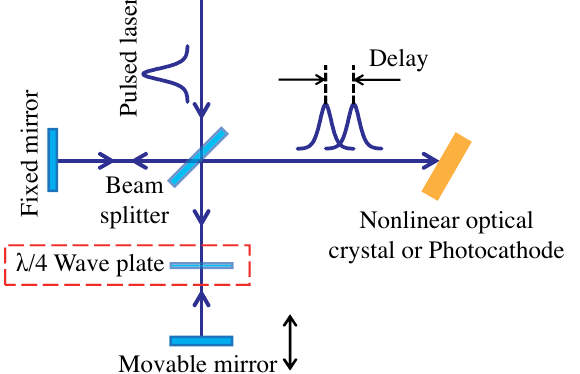
FIG. 1. Schematic of the time delay optical path for an autocorrelation measurement. The incident laser pulse is divided into two pulses with a certain time delay and then are incident to a nonlinear optical crystal or a photocathode. The time delay is adjusted by moving the movable mirror back and forth. The λ = 4 wave plate is used to rotate the polarization of the beam passing through it twice by 90°.